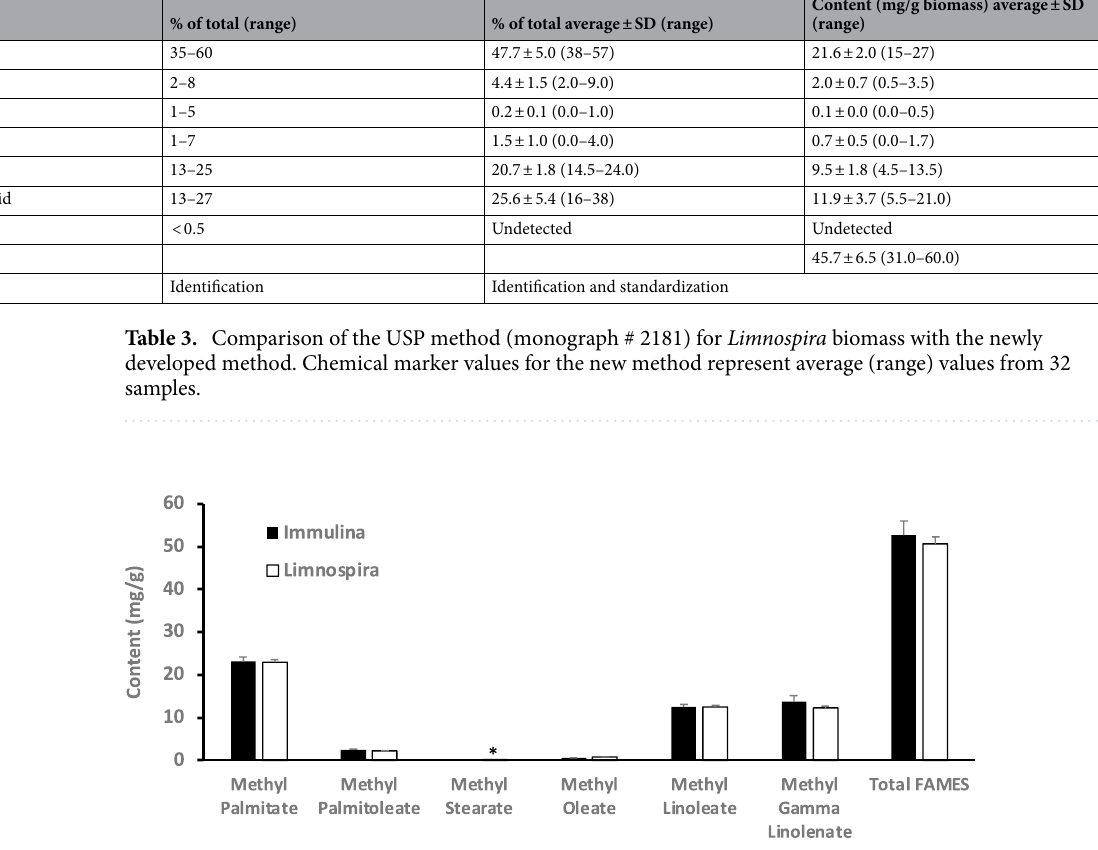
Figure 2. Comparative content of each FAME in dried Limnospira and commercial extract, Immulina, extracted from the same batch of dried biomass. Bars represent the average ± SD of three samples from the same batch of material. Each sample was analyzed in duplicate in the GC–MS. No statistically significant differences were observed between sample means, except for methyl stearate (compared by paired t-tests). * p =